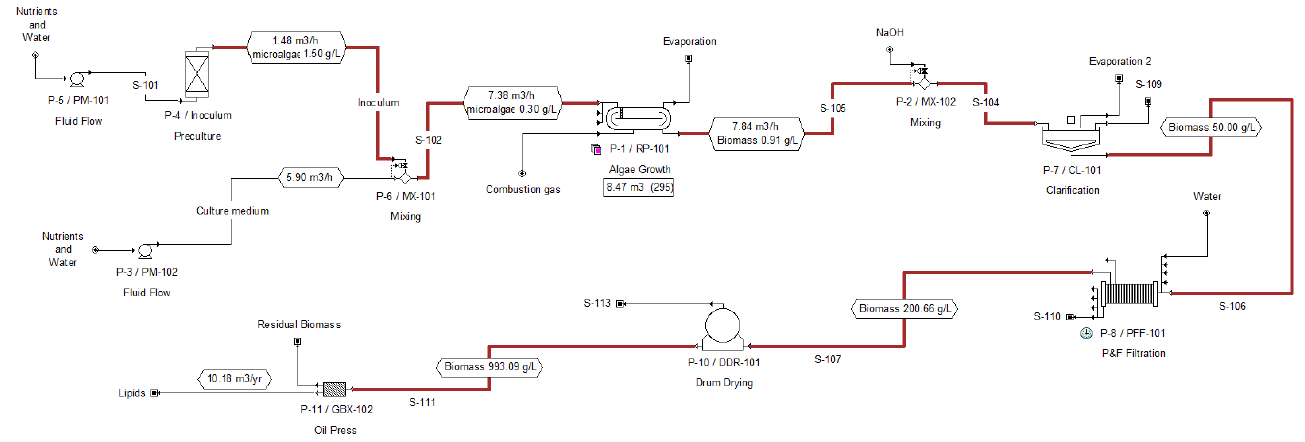
Figure 4. Flowsheet in SuperPro Designer for the production of lipids from dry biomass, scenario 3. Table 3. Operating conditions for the technologies involved in the pretreatment stage (cell disruption).